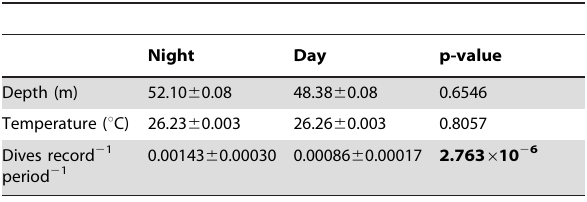
Table 2. Night and day mean ( 6 SE) depth (m), temperature ( u C), and number of dives ( . 200 m) record 2 1 period 2 1